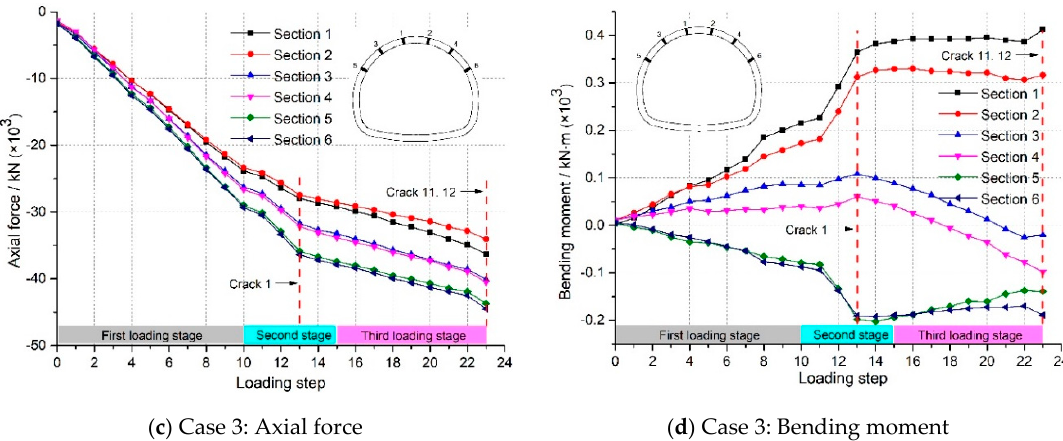
Figure 17. Internal force curves of the arch Sections 1–6: ( a ) axial force in case 1, ( b ) bending moment in case 1, ( c ) axial force in case 3, and ( d ) bending moment in case 3.